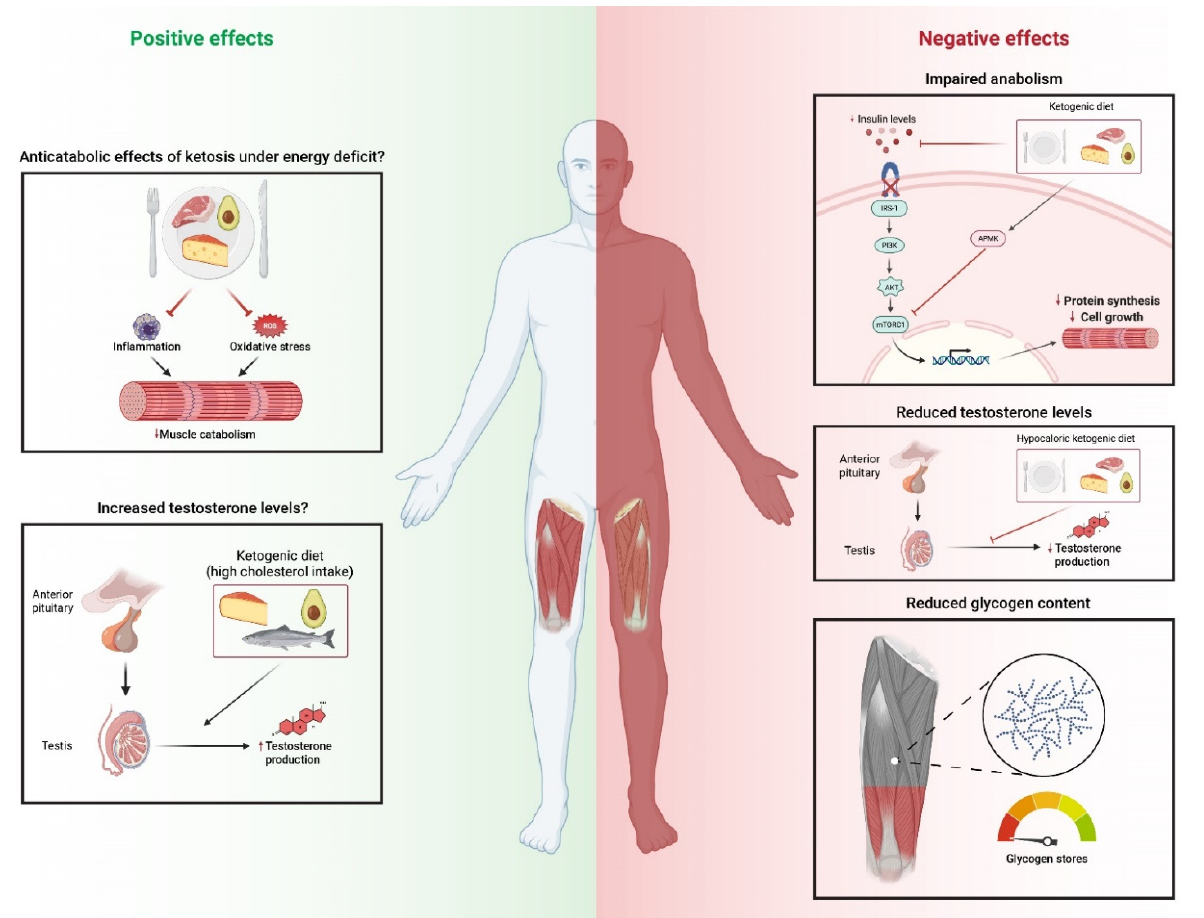
Figure 2. Summary of some potential mechanisms underlying the positive and negative effects of ketogenic diets on muscle mass.